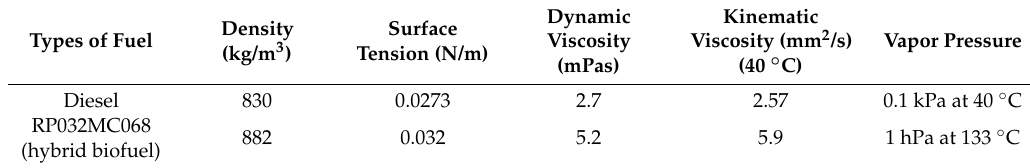
Table 1. Material properties of the diesel and RP032MC068 blends.